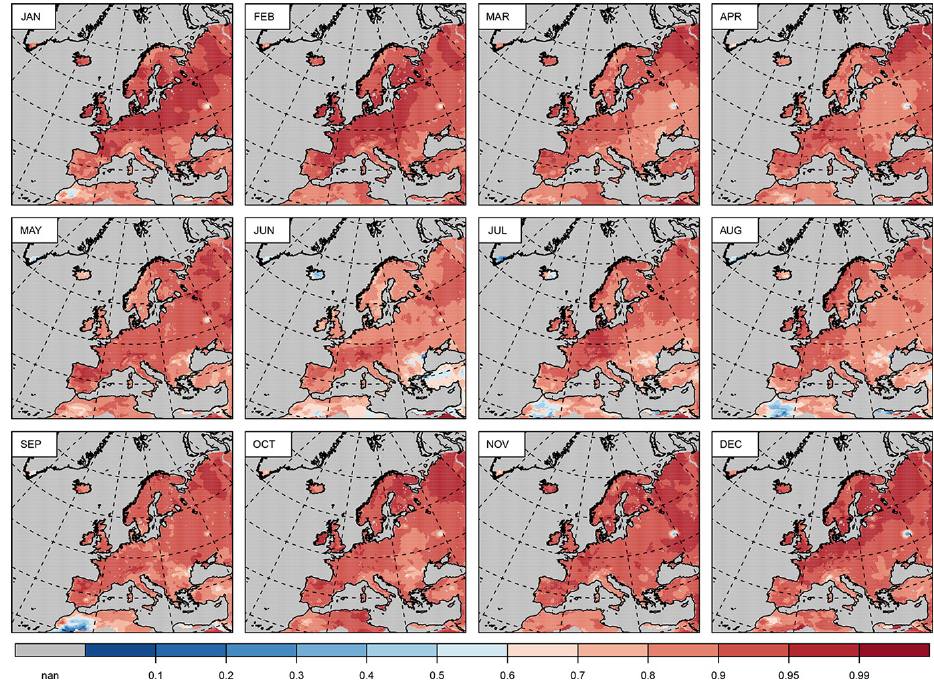
Figure 4. Correlations between coastDat2-CCLM and E-OBS8.0 of monthly mean 2m air temperatures from 1950 to 2012.